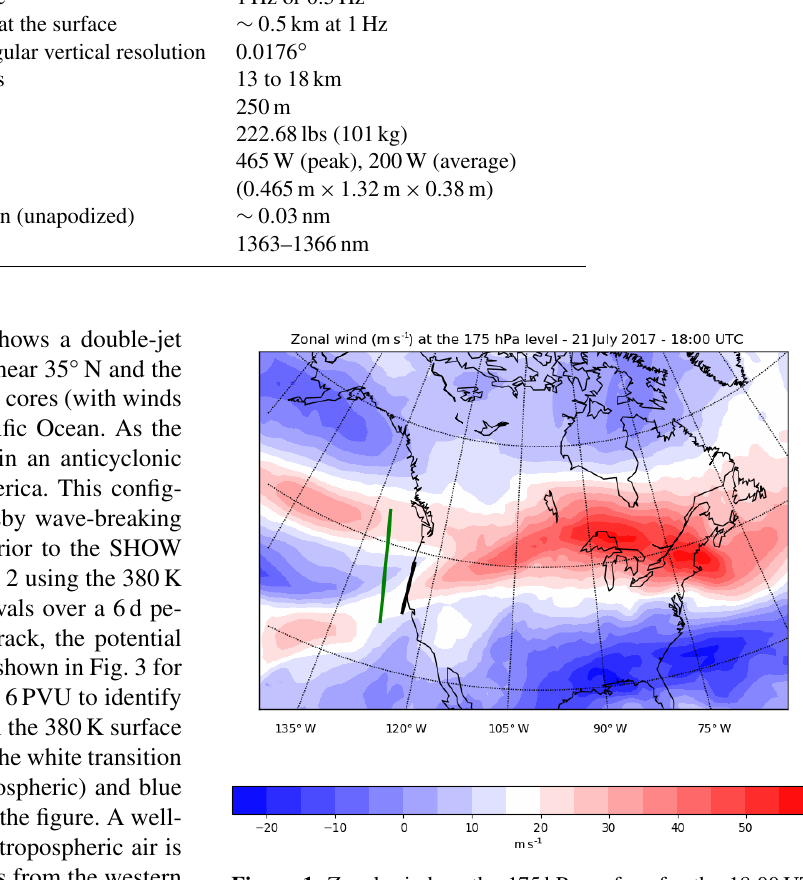
Figure 1. Zonal wind on the 175hPa surface for the 18:00UTC, 21 July 2017, time step. The ER-2 flight track with the SHOW mea- surements is shown as the black line, and the closest measurement track of the AURA–MLS instrument is shown as the dark green